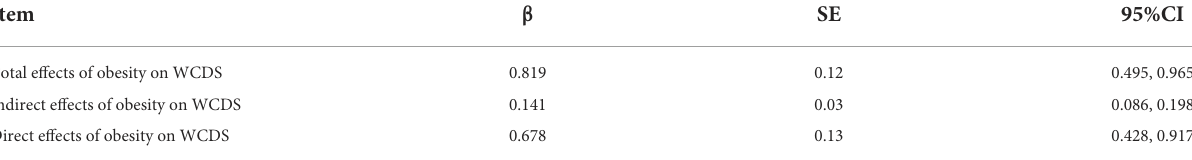
TABLE 4 Total, direct and indirect effects of obesity on weight control behavior scores (WCDS).